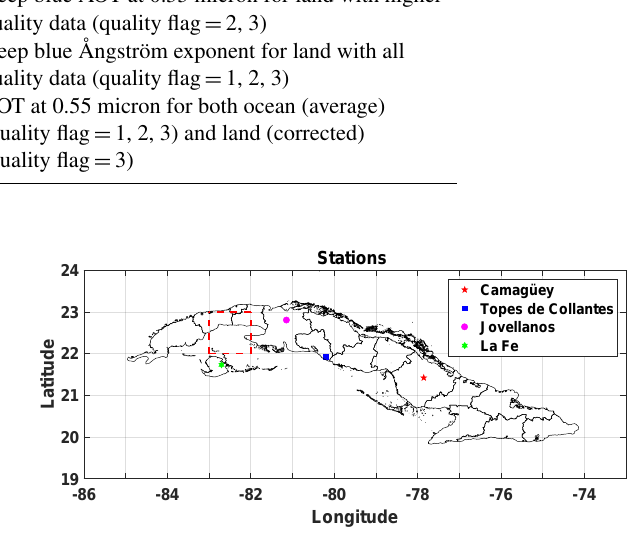
Figure 1. Map of Cuba with the stations where the sun photometer and the four broadband pyrheliometer observations are